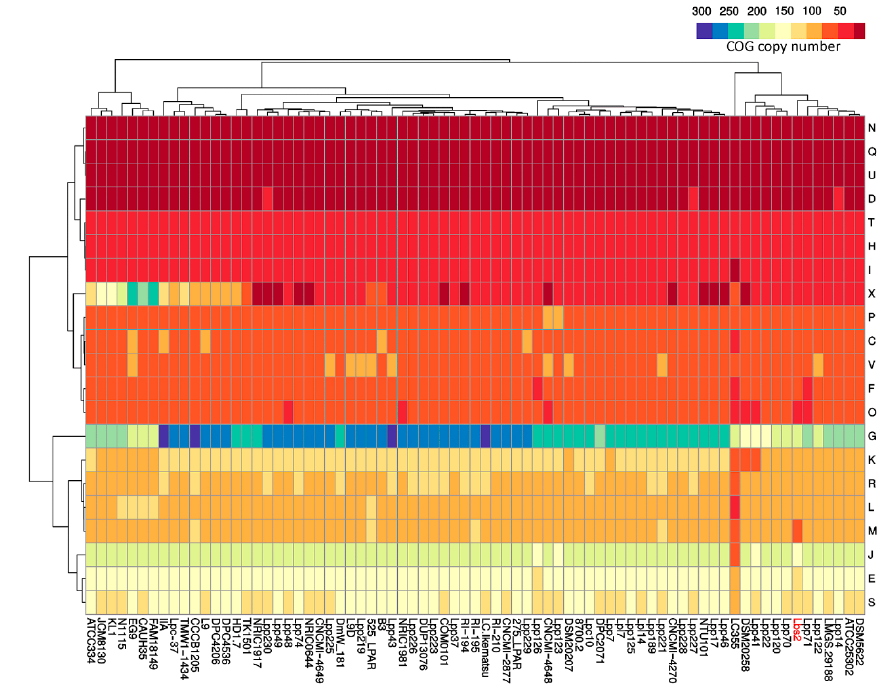
Figure 2. Cluster of Orthologous Groups (COG) frequency heatmap based on hierarchical clustering. The horizontal axis depicts functional COG categories, and the vertical axis represents 75 L. paracasei strains. Genome of interest ‘Lbs2’ is marked as red.